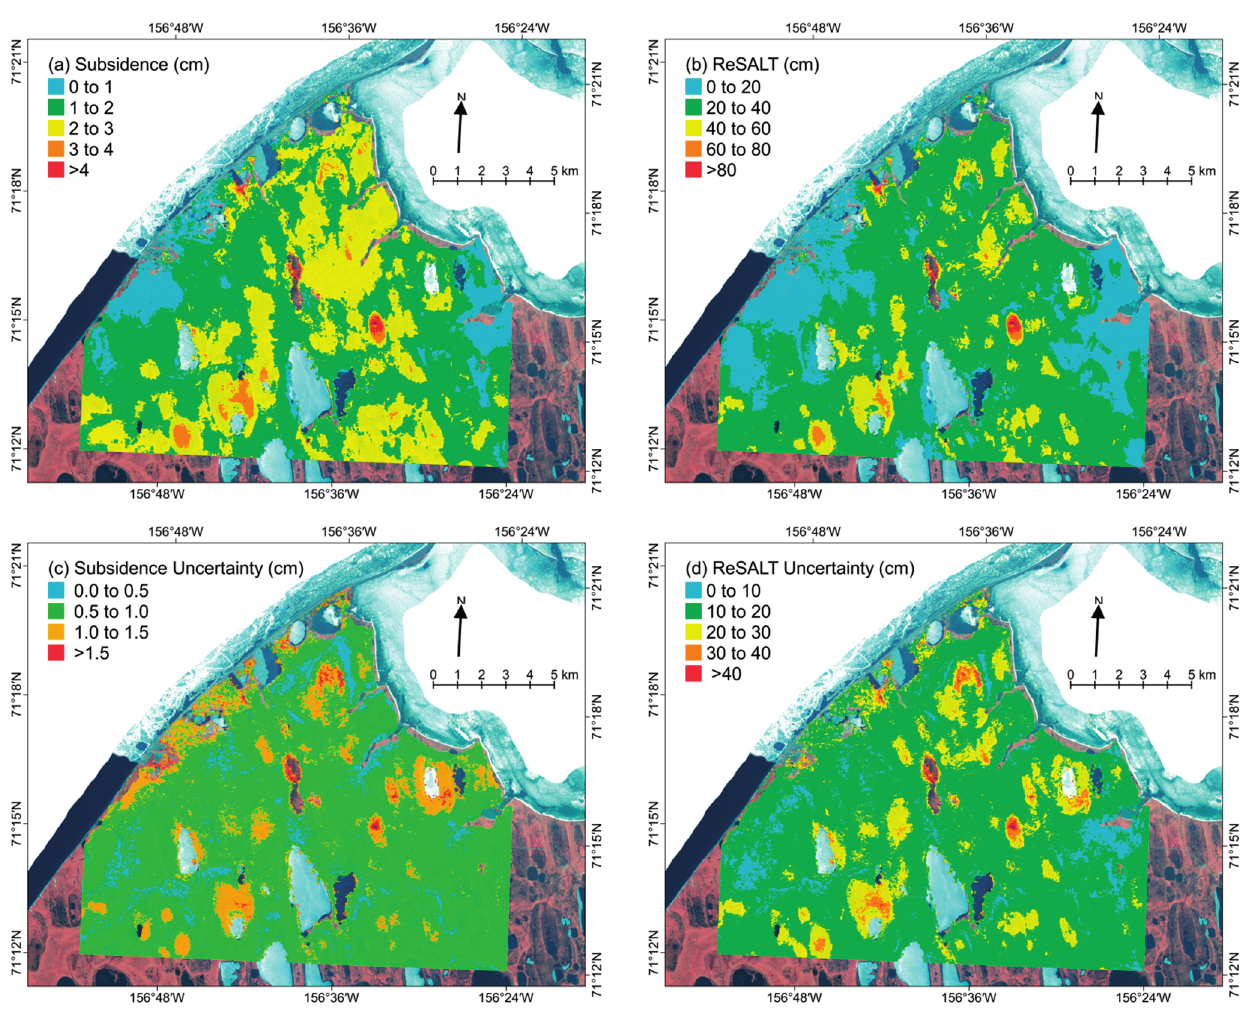
Figure 3. The 2006–2010 average seasonal subsidence from Interferometric Synthetic Aperture Radar (InSAR) ( a ); ReSALT ( b ) and associated uncertainties ( c , d ). Locations with no coherent signal are left